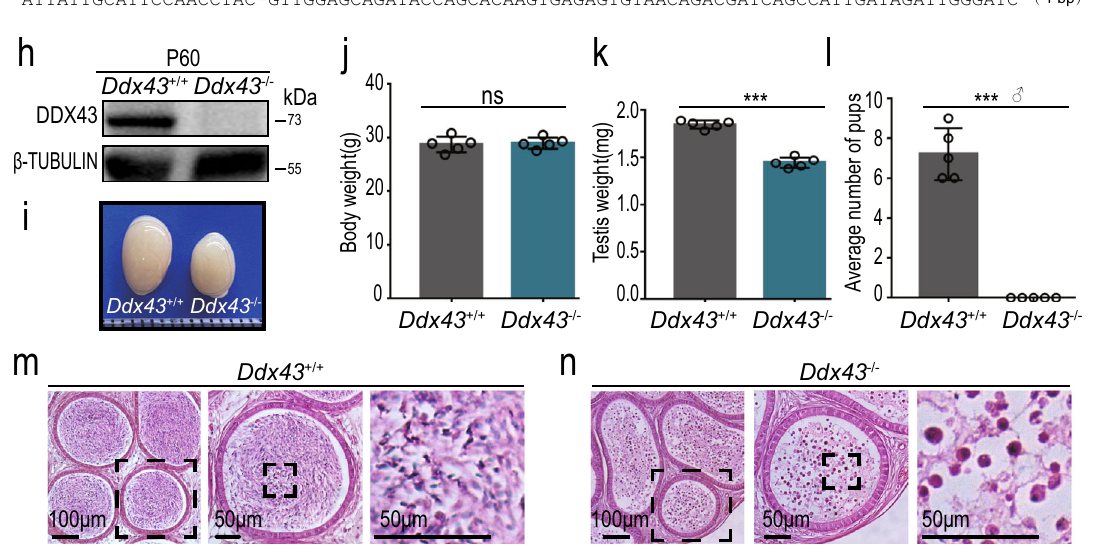
head shape and excess cytoplasm (Fig. 2f; red arrows). These con- densedrod-or round-like abnormalelongated spermatidsfrequently appeared in stages IX – XI (Fig. 2f; red arrows). In Ddx43 mutant